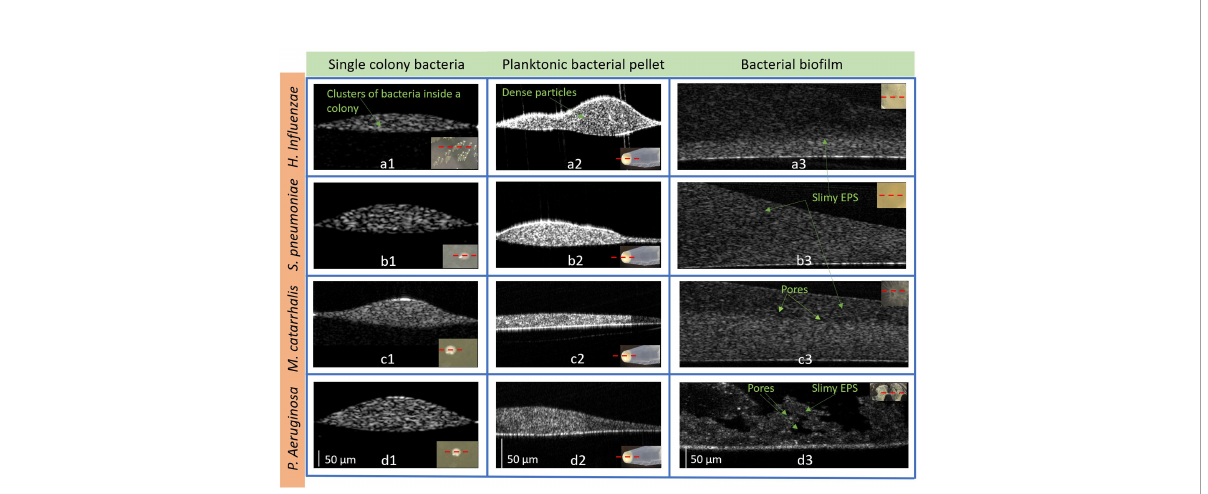
FIGURE 5 Representative 2D OCT images from H. In fl uenzae (a1) single-colony, (a2) planktonic (in pellet), and (a3) bio fi lm; S. pneumoniae (b1) single- colony, (b2) planktonic (in pellet), and (b3) bio fi lm; M. catarrhalis (c1) single-colony, (c2) planktonic (in pellet), and (c3) bio fi lm and P. aeruginosa in (d1) single-colony, (d2) planktonic (in pellet), and (d3) bio fi lm. The lower right insets show photos of the bacteria in each form. (Supplementary Figure S3: Representative 3D OCT images from P. aeruginosa are shown in (a) a single-colony, (b) planktonic (in pellet) and (c) bio fi lm and 3D videos of the three